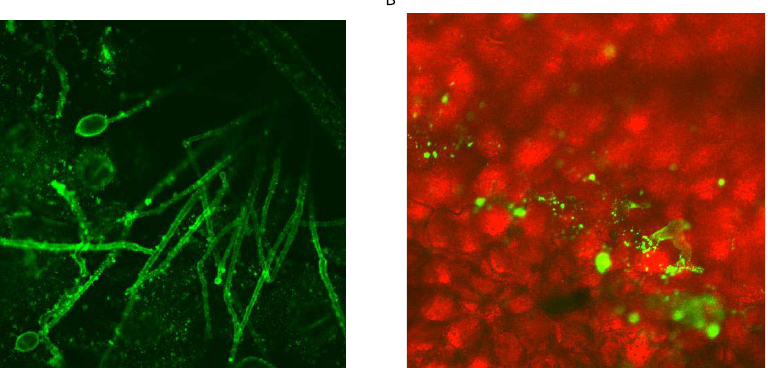
Figure 4. Immunofluorescent detection of hyphae and sporangia of P. infestans . Primary antibodies were prepared to a peptide representing the amino terminus (after signal peptide cleavage) of CBD1. Samples were viewed by confocal microscopy after incubation with FITC labeled secondary antibodies. A) hyphae and sporangia emerging from infected potato leaf tissue B) hyphae along the transition zone between symptomatic (upper right) and asymptomatic (lower left) infected leaf